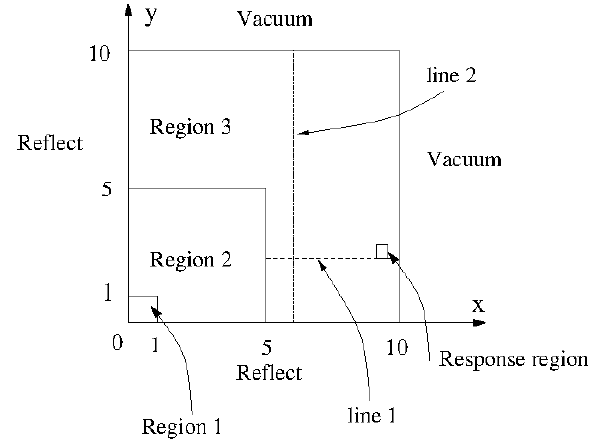
Figure 1. Maynard problem domain, dimension stated in